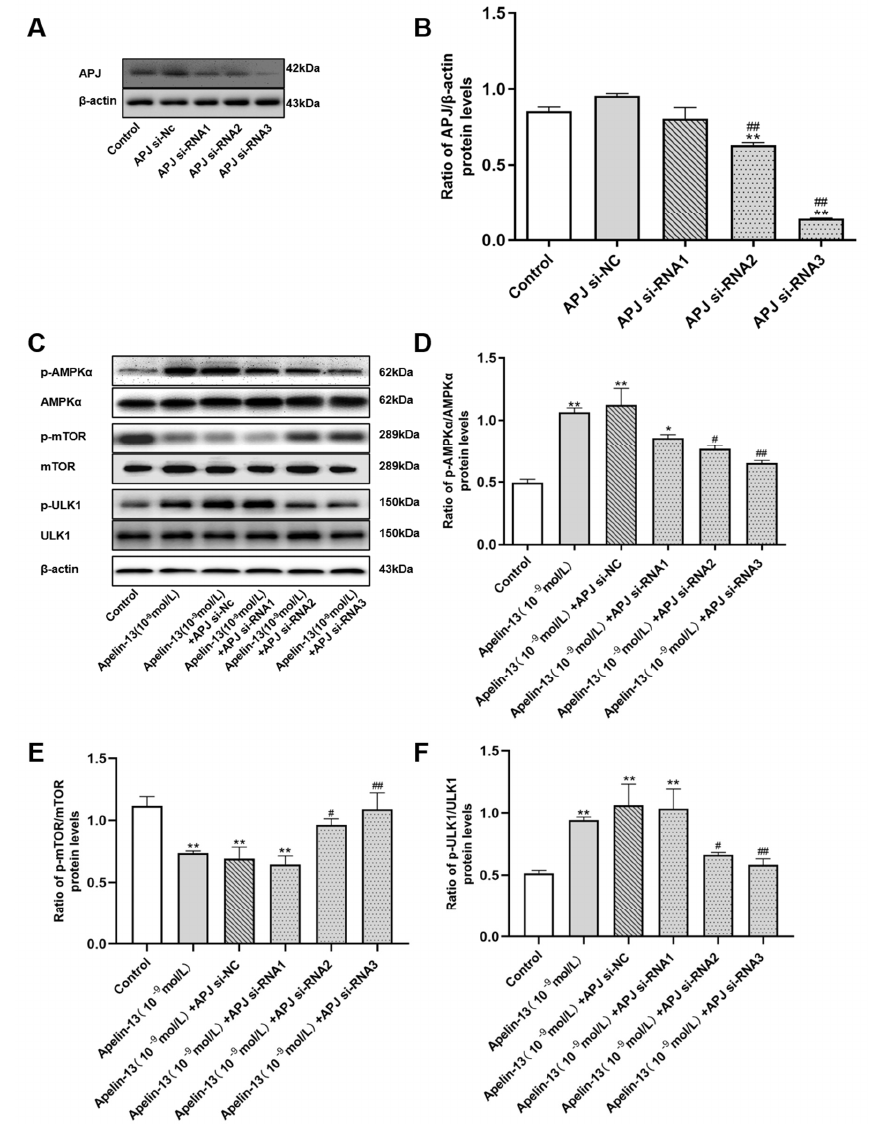
Figure 10. E ff ects of apelin receptor (APJ) siRNA on the AMPK / mTOR / ULK1 signaling pathway in SH-SY5Y cells with apelin-13 treatment. ( A , B ) SH-SY5Y cells were transfected with APJ siRNA. Western blot was applied to detect the APJ protein expression. The expression of APJ protein was inhibited by siRNA. ( C – F ) SH-SY5Y cells were treated with apelin-13 or pre-treated with APJ siRNA prior to apelin-13. Western blot was applied to detect the phosphorylated and total AMPK α , mTOR, and ULK1. Phosphorylation of AMPK α and ULK1 were attenuated in apelin-13 treated cell with APJ siRNA, while phosphorylation of mTOR was increased. Data are presented as mean ± SEM of three replications. * p < 0.05; ** p < 0.01 compared with the control; # p < 0.05; ## p < 0.01 compared with the apelin-13